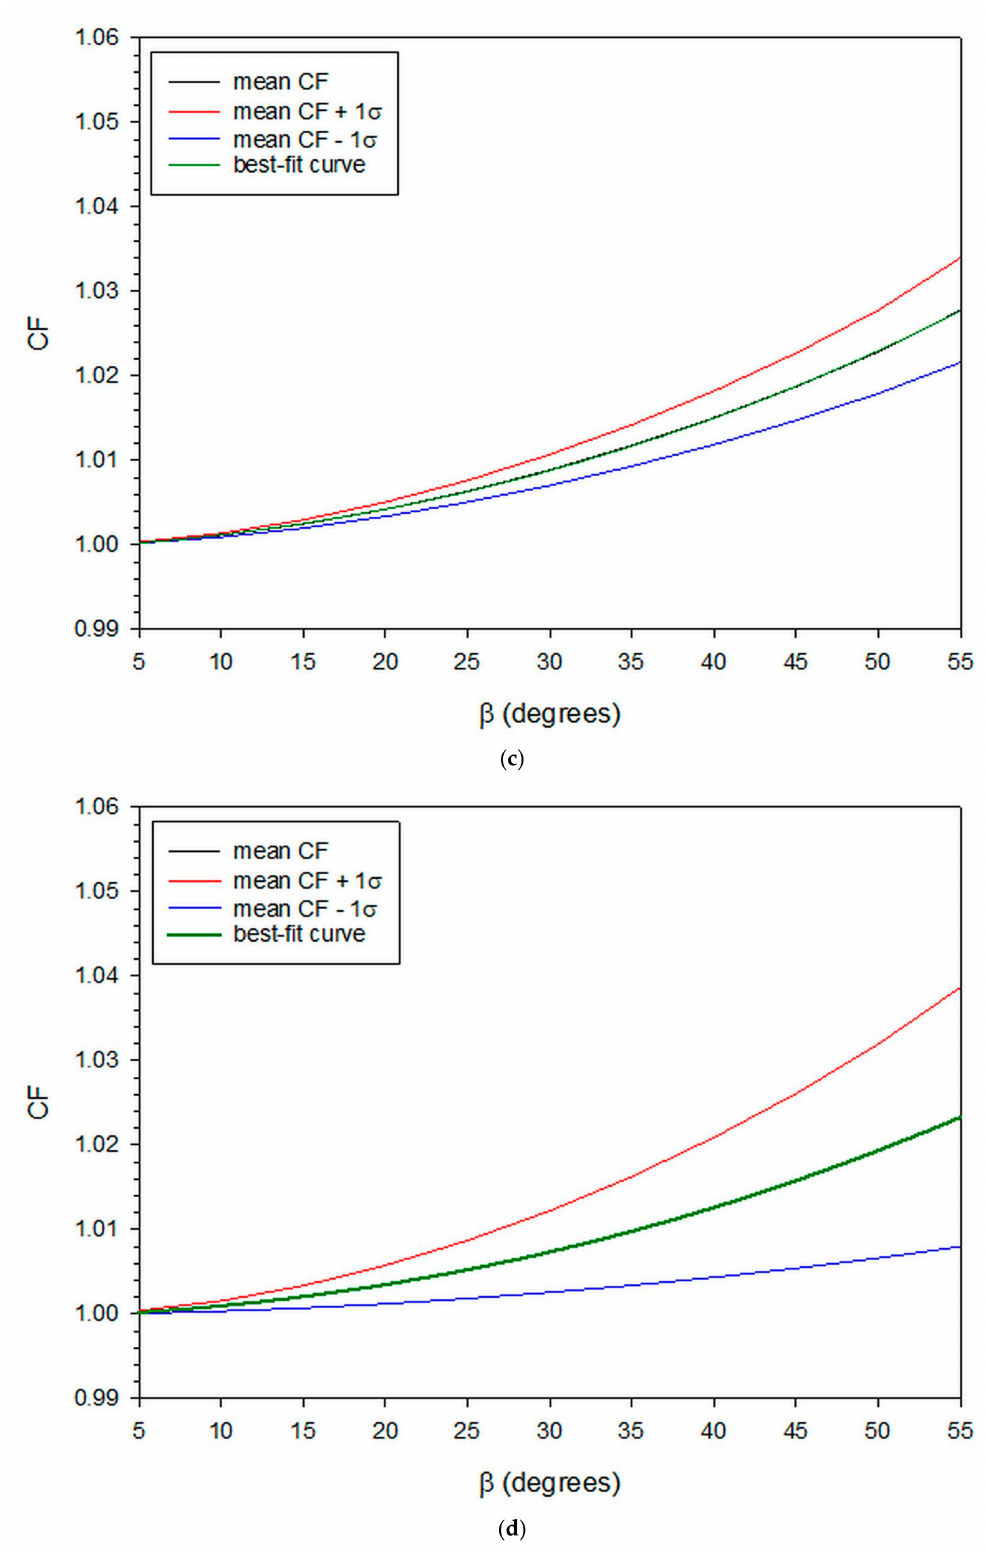
Figure 13. Variation of the correction factor, CF, as function of the tilt angle, β , for an inclined surface in ( a ) SEZ-A, ( b ) SEZ-B, ( c ) SEZ-C, and ( d ) all SEZs, averaged over the period 2005–2016. The black solid lines are the mean CF values, while the red and blue ones correspond to the mean + 1 σ , and mean − 1 σ , respectively. The green dotted lines are the best fits to the mean curves and can hardly be distinguished as they coincide with the mean